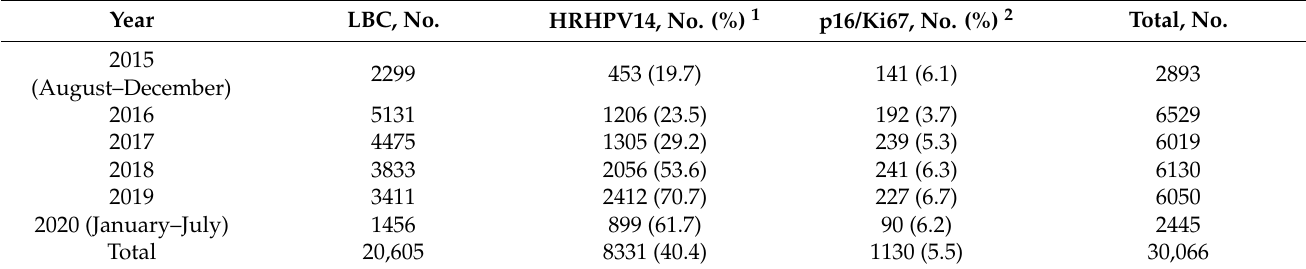
Table 3. Numbers of LBC, HRHPV14, and p16/Ki67 tests by year between August 2015 and July 2020.